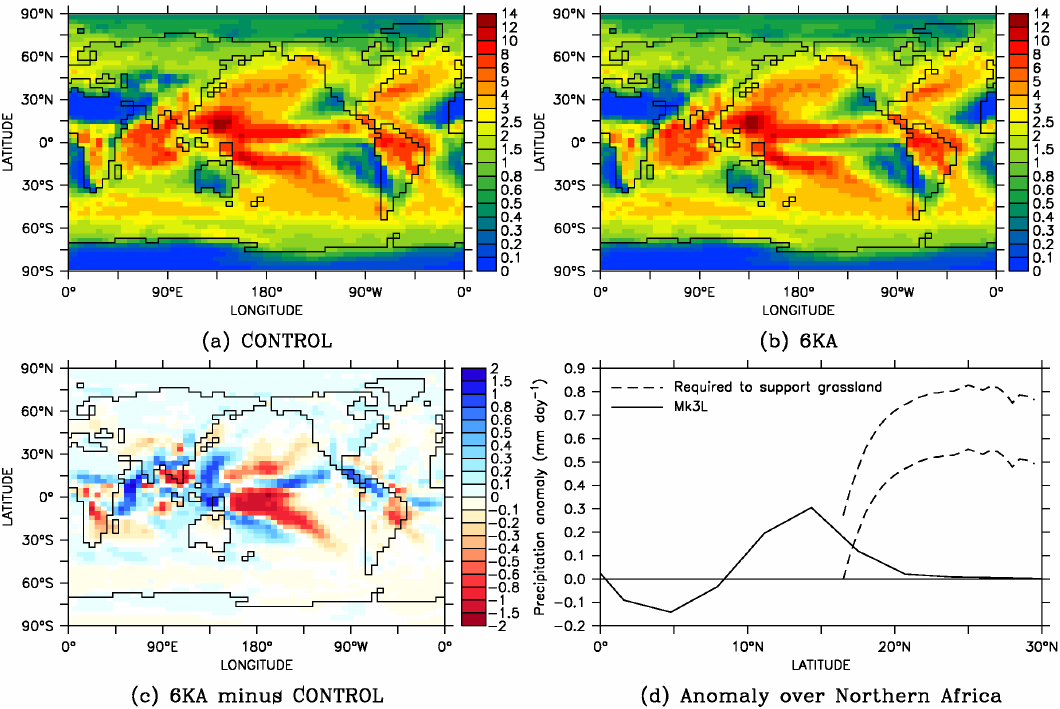
Fig. 3. The annual-mean precipitation (mmday − 1 ) for years 201–1200 of experiments CONTROL and 6KA: (a) CONTROL, (b) 6KA, (c) 6KA minus CONTROL, and (d) the zonal-mean difference over Northern Africa (20 ◦ W–30 ◦ E). In (c) , only values that are significant at the 95% confidence level are shown. In (d) , minimum and maximum estimates of the precipitation increase required to support grassland at each latitude are also shown (Joussaume et al.,